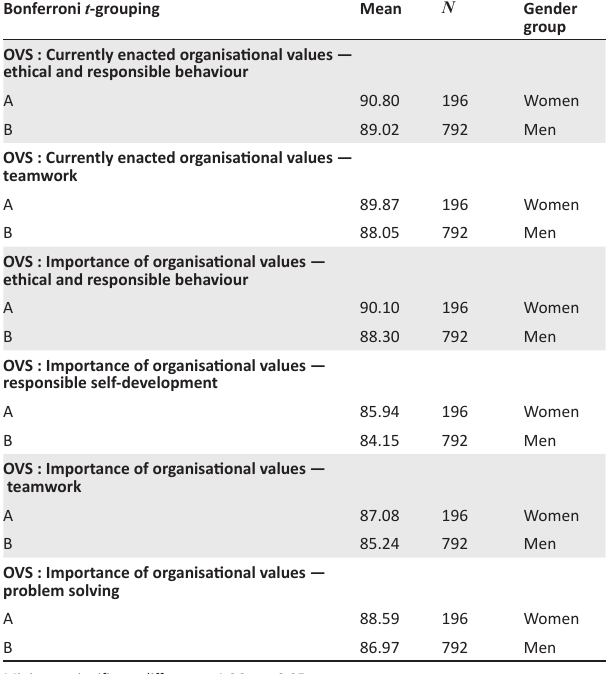
TABLE 5: Summary results – Bonferroni (Dunn) t-test for significant mean differences (gender) ( n = 988). Bonferroni t